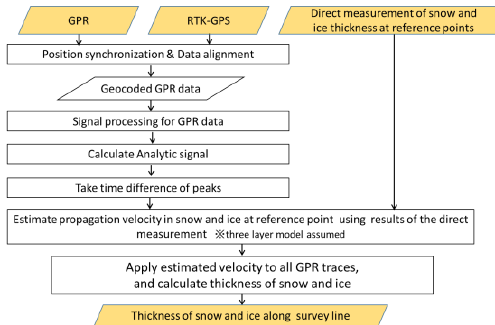
Figure 3. Flow chart of ice thickness measurement by